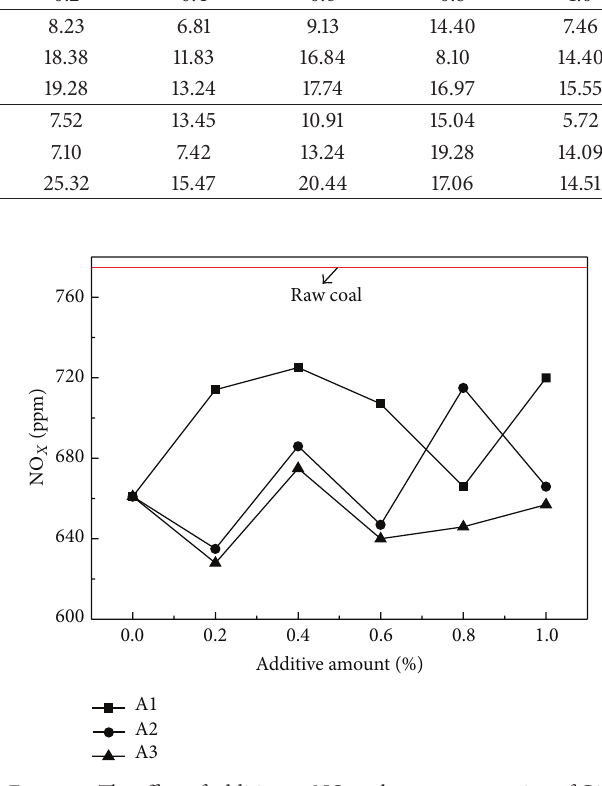
Figure 4: The effect of additive on NO 𝑋 release concentration of C1. Figure 5: The effect of additive on NO 𝑋 release concentration of C2.